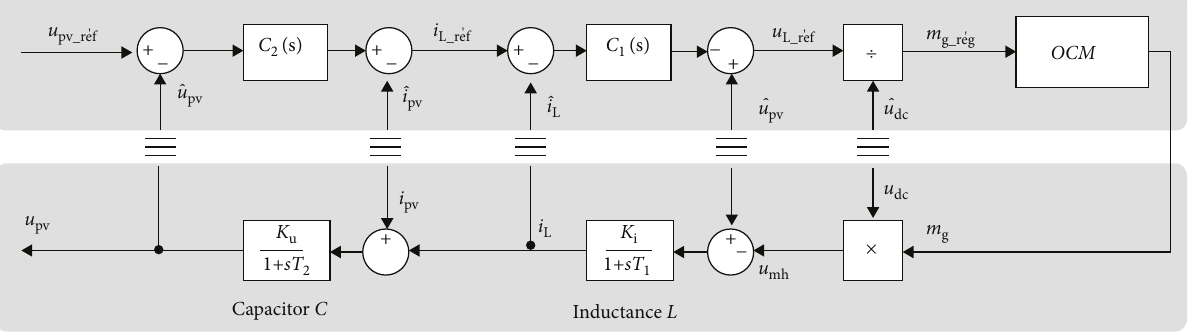
Figure 2: Block diagram of the PVG